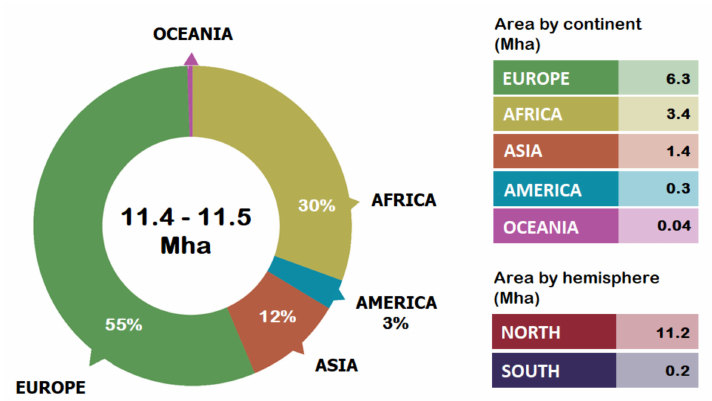
Figure 2. Total area planted with olive groves by continent and